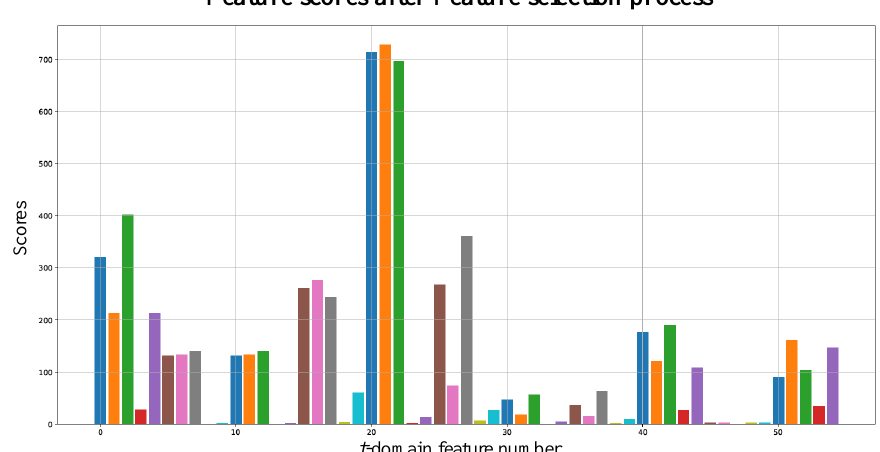
Figure 14. Scores of the feature selection step and list of t -domain